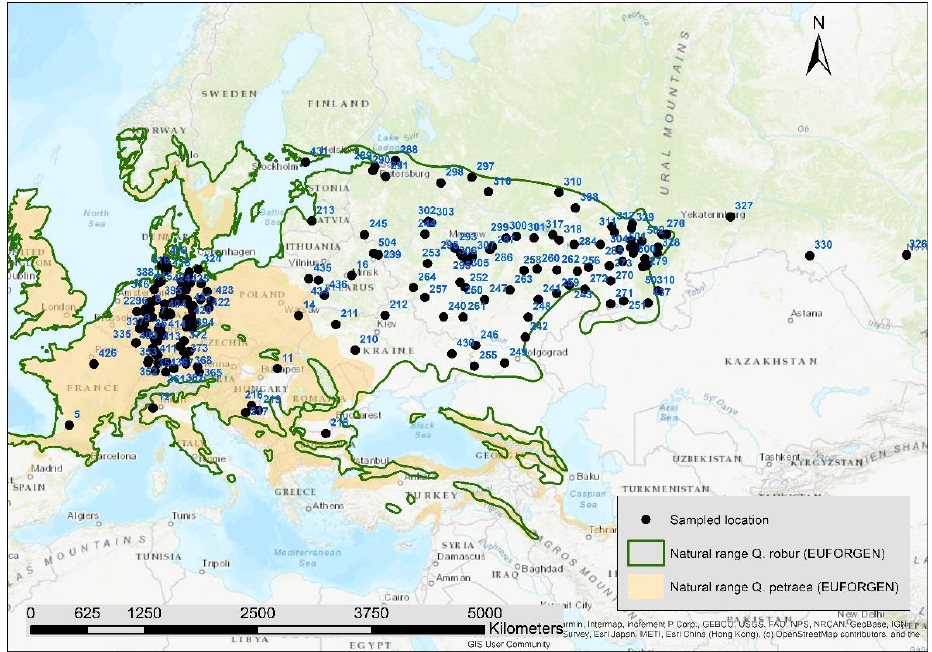
Figure 1. Position of the 197 sampled locations, the numbers are the location-IDs in Table S1 (Supplementary), natural ranges of Quercus robur and Quercus petraea according to EUFORGEN.